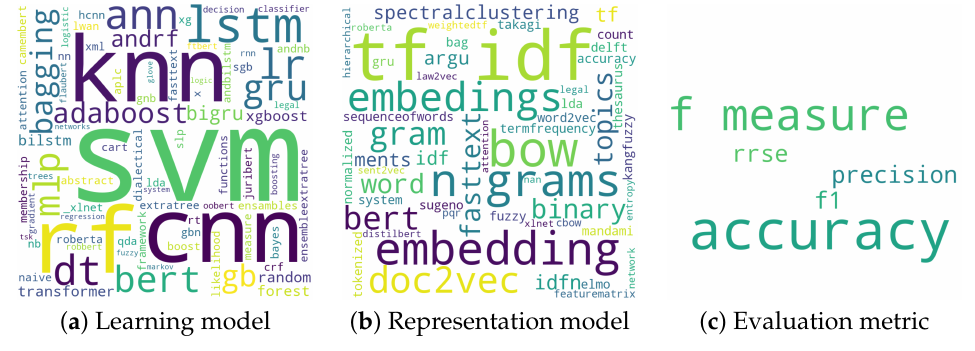
Figure 4. Word cloud